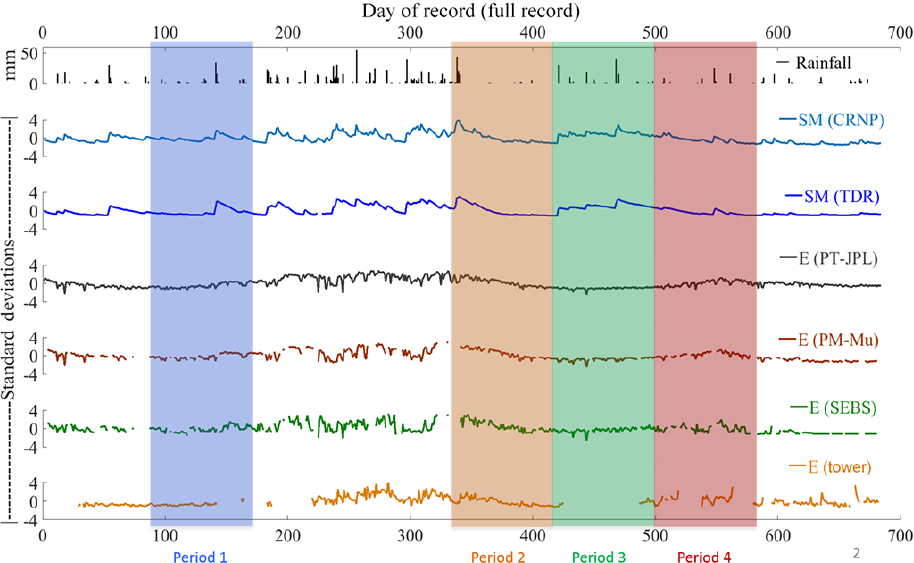
Figure 3. Standardized soil moisture (CRNP and TDR), evaporation (modelled and observed), and precipitation signatures for the entire duration of record.